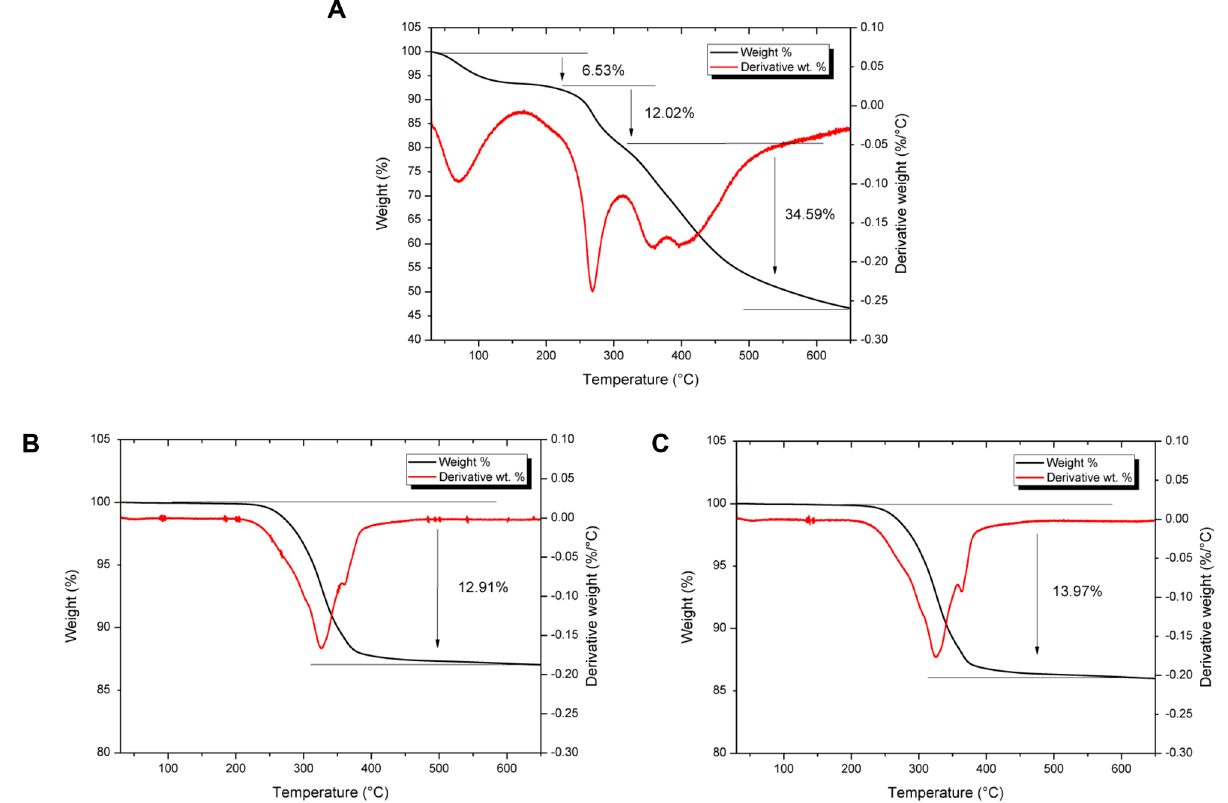
Figure 5. Thermal stability of Teic immobilised on the surface of TiO 2 using Thermal Gravimetric Analysis (TGA). TiO 2 powder (50 mg) was incubated with either 500 µl of Teic (500 µg/ml) in HEPES (50 mM; pH 7.4) buffer or HEPES buffer alone as a control for 2 h under ambient conditions and then centrifuged at 11,300 × g for 2 min. The centrifuged pellets were air dried at room temperature before undergoing TGA. ( A ) Percentage weight curves for Teic alone shows an initial decrease at temperatures below 100 °C due to moisture evaporation. This was followed by rapid thermal degradation at temperatures greater than 250 °C. ( B ) TiO 2 samples incubated in HEPES buffer showed a single dissociation step between 250 °C and 400 °C and a percentage weight change of 12.91%. ( C )Similar percentage weight and derivative weight curves were obtained for TiO 2 samples incubated with Teic, however a greater weight loss of 13.97% was observed between 250 °C and 400 °C indicating the additional dissociation of Teic from the surface of TiO 2 at high